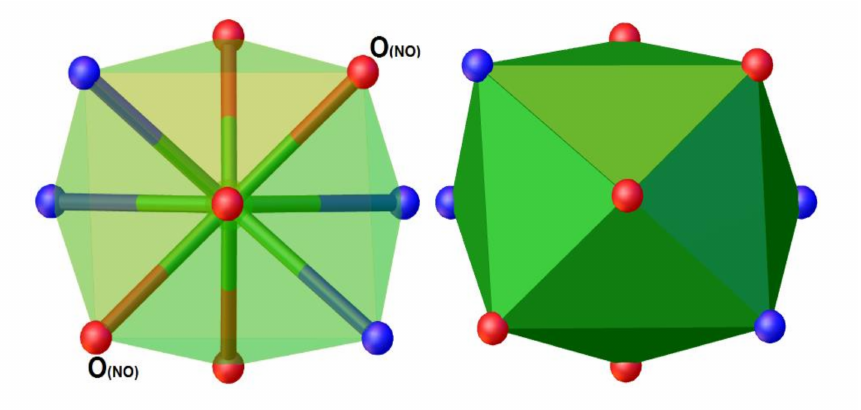
Figure 2. The LnO 5 N 4 polyhedron-spherical capped square